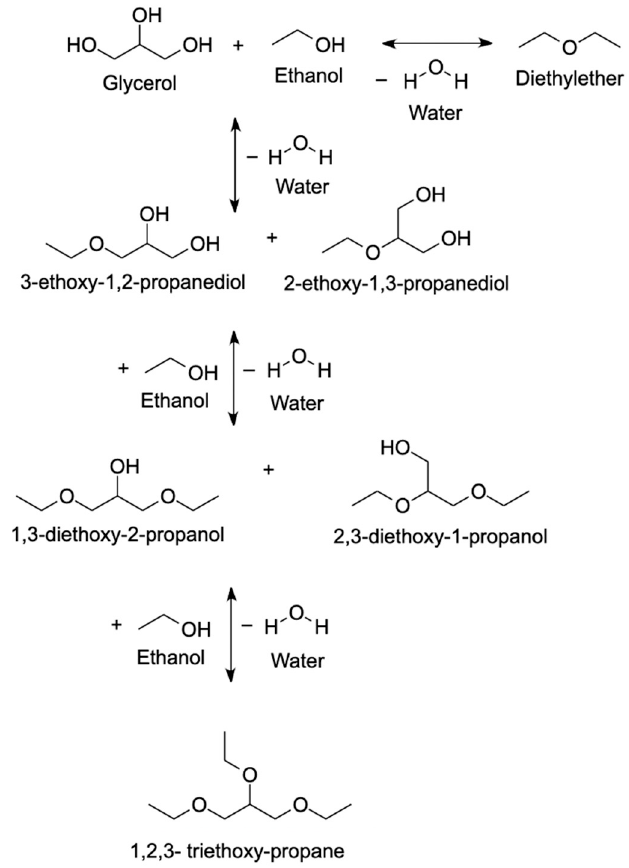
Figure 7. Reaction mechanism of glycerol etherification with ethanol [93].